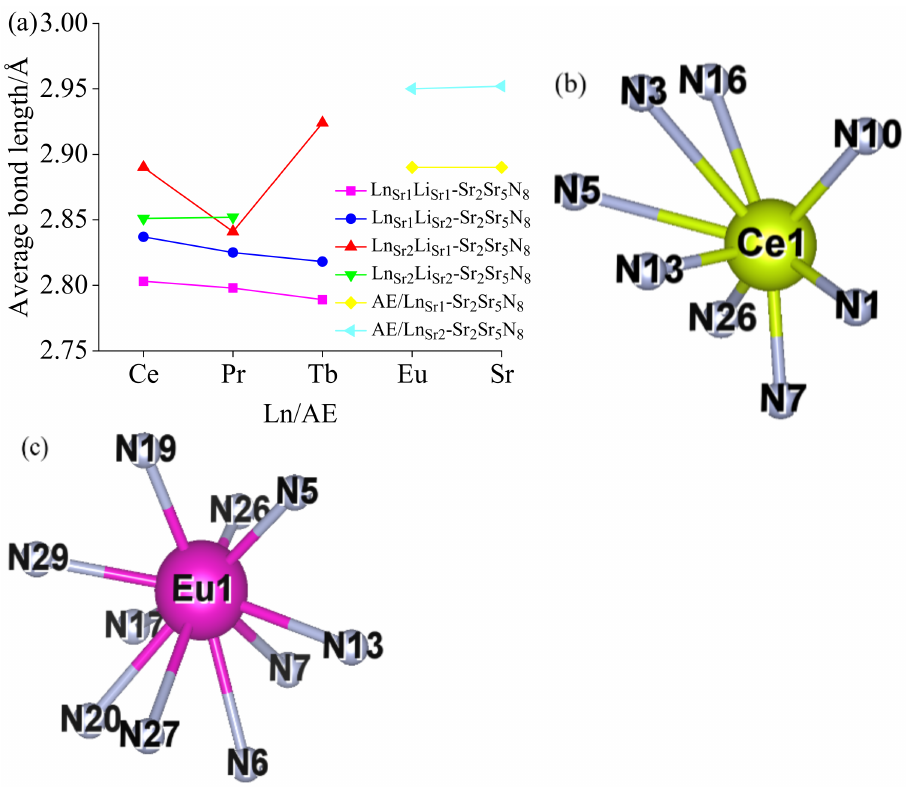
Figure 1. ( a ) Average bond length of [LnN 8 ] and [LnN 10 ]. ( b ) Structure diagram of [CeN 8 ]. ( c ) Structure diagram of [EuN 10